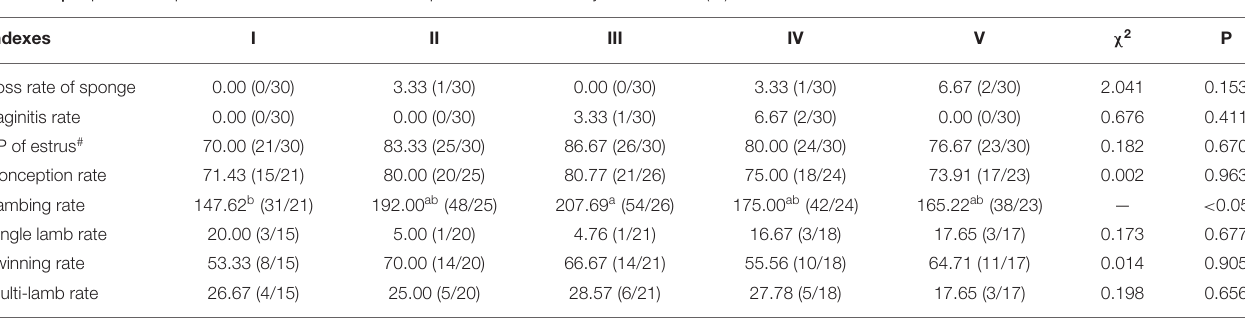
TABLE 2 | Reproductive performance of Hu ewes with five protocols of estrous synchronization (%).